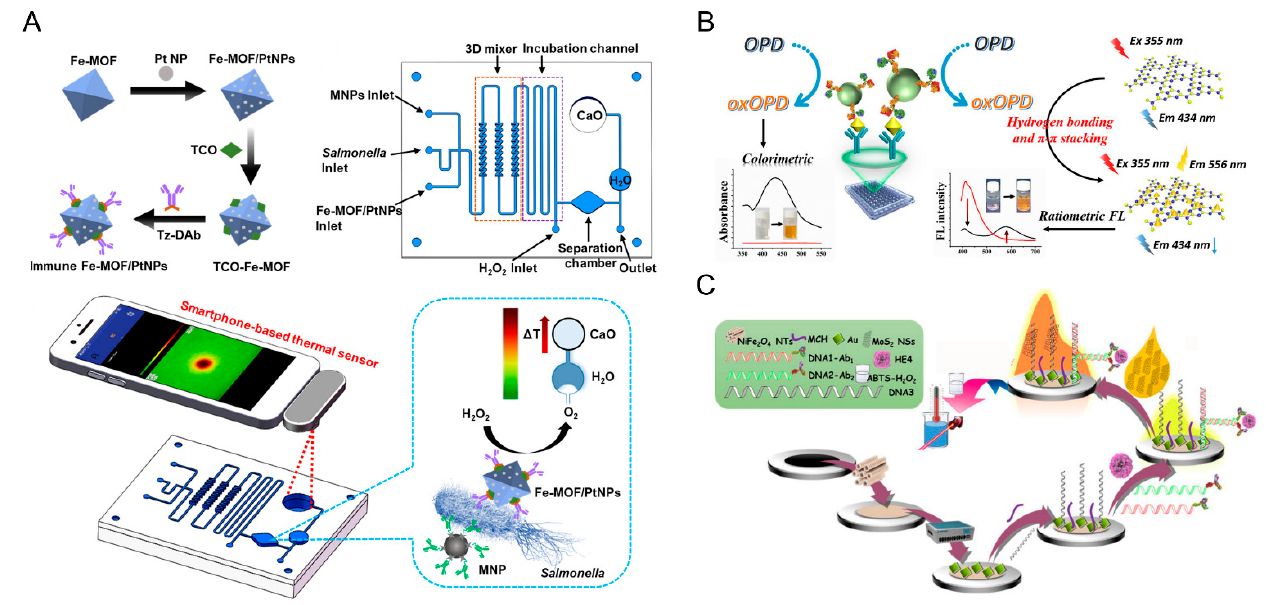
Figure 6. ( A ) Schematic diagram of the microfluidic immunosensor for Salmonella detection [75]. Reprinted with permission from ref [75]. Copyright 2021 American Chemical Society. ( B ) Schematic illustration of the principle of nanozyme-linked immunosorbent assay for dual colorimetric and ra- tiometric fluorescent determination of cTnI [76]. Reprinted with permission from ref [76]. Copyright 2019 Elsevier. ( C ) Schematic illustration of the proximity hybridization-based multiple stimuli-responsive immunosensing platform for ECL, colorimetry and photothermal sensing of ovarian cancer biomark- ers [78]. Reprinted with permission from ref [78]. Copyright 2020 Elsevier.